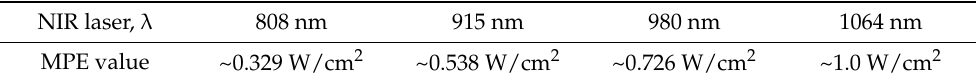
Table 1. Calculated safe power densities of common NIR lasers [19] (MPE—maximum permissible exposure, NIR—near-infrared). NIR laser, λ 808